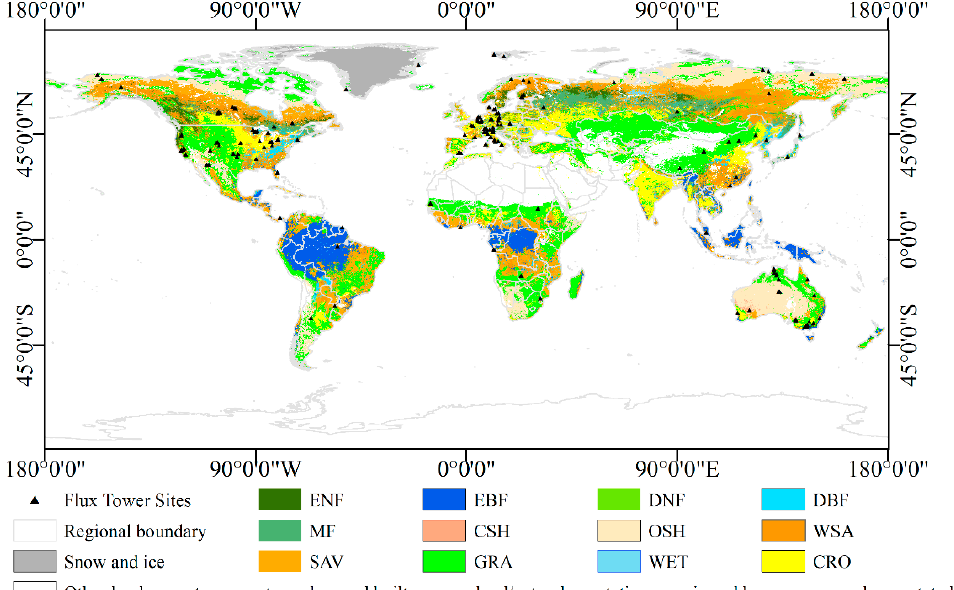
Figure 1. The spatial distribution of all the 212 eddy-covariance (EC) flux tower sites from the FLUXNET 2015 Tier 1 dataset, depicted by black triangles. Biomes in the legend are from a static land cover map (MCD12C1 Land Cover Type 1: IGBP global vegetation classification scheme for 2007) retrieved from Friedl and McIver [38]. Biomes are: croplands (CRO), closed shrublands (CSH), deciduous broadleaf forest (DBF), deciduous needleleaf forest (DNF), evergreen broadleaf forest (EBF), evergreen needleleaf forest (ENF), grasslands (GRA), mixed forests (MF), open shrublands (OSH), savannas (SAV), permanent wetlands (WET), and woody savannas (WSA).